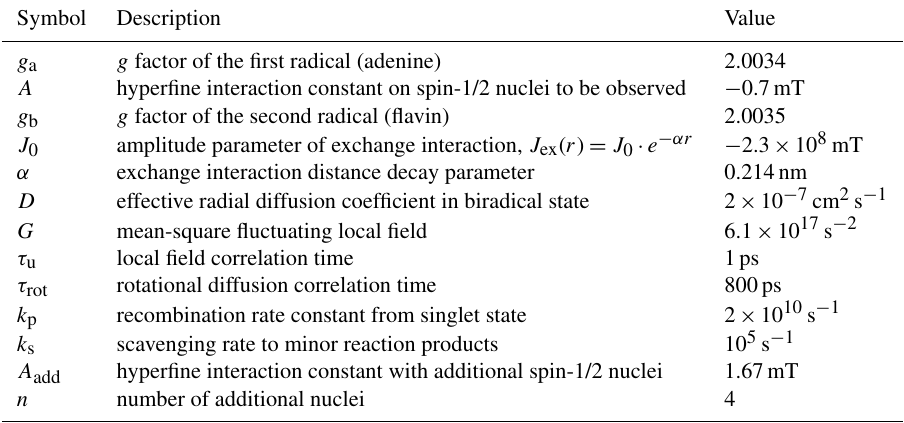
Table 1. Parameters used to model the CIDNP field dependence. Symbol